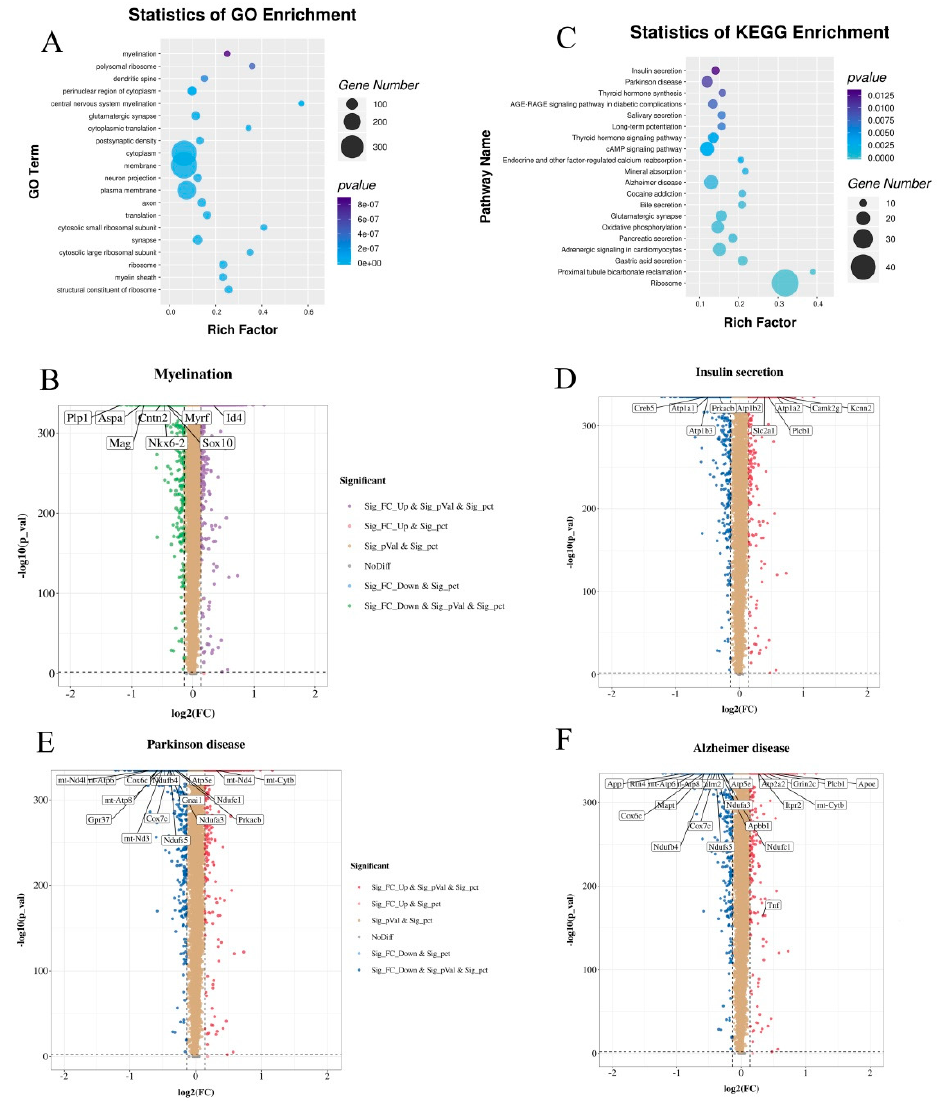
Figure 6. Effects of CPF intervention on gene enrichment pathways in the hypothalamus: ( A ) GO classification analysis of DEGs in the hypothalamus between the CD and CPF groups. ( B ) The regulation of CPF intervention on DEGs involved in myelination of the CNS. ( C ) KEGG classification analysis of DEGs in the hypothalamus between the CD and CPF groups. ( D ) The regulation of CPF intervention on DEGs involved in insulin secretion. ( E ) The regulation of CPF intervention on DEGs involved in Parkinson disease. ( F ) The regulation of CPF intervention on DEGs involved in Alzheimer disease.